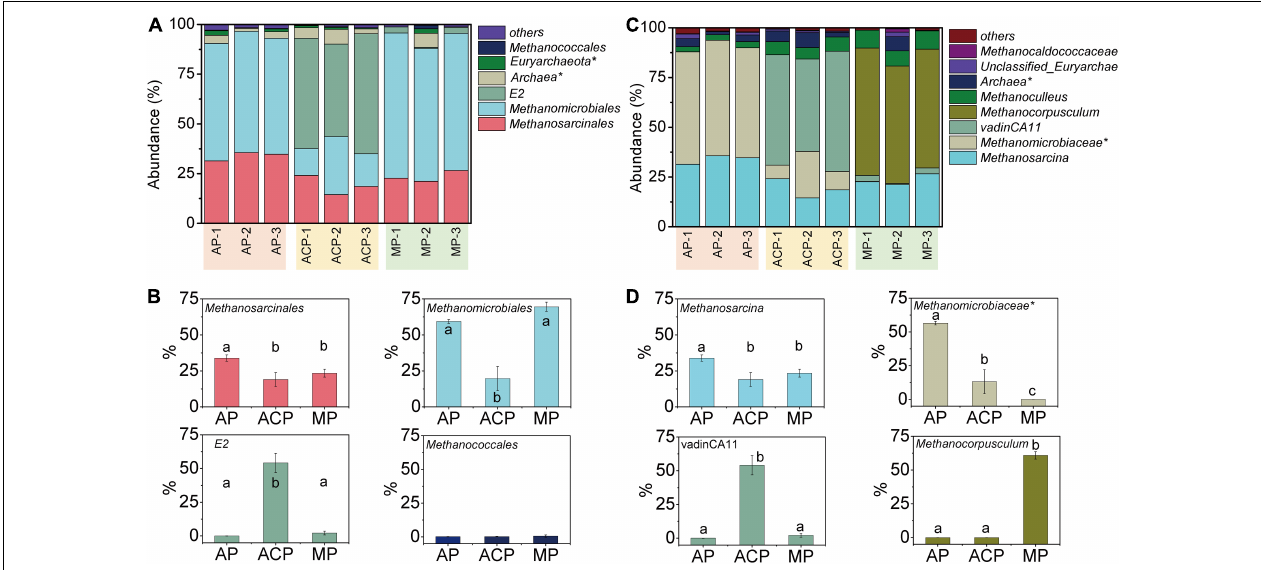
FIGURE 3 | Methanogen community composition in order level (A) and genus level (C) and main order (B) and genus (D) changed in solid waste samples during solid waste decomposition. Phylogenetic groups accounting for ≥ 0.50% of the sequences are summarized in the artificial group “others.” AP, aerobic phase ( n = 3);